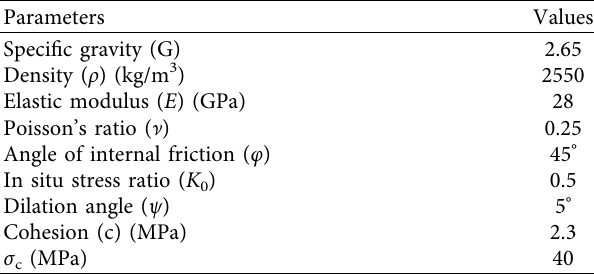
Table 2: Properties of quartzite rock mass